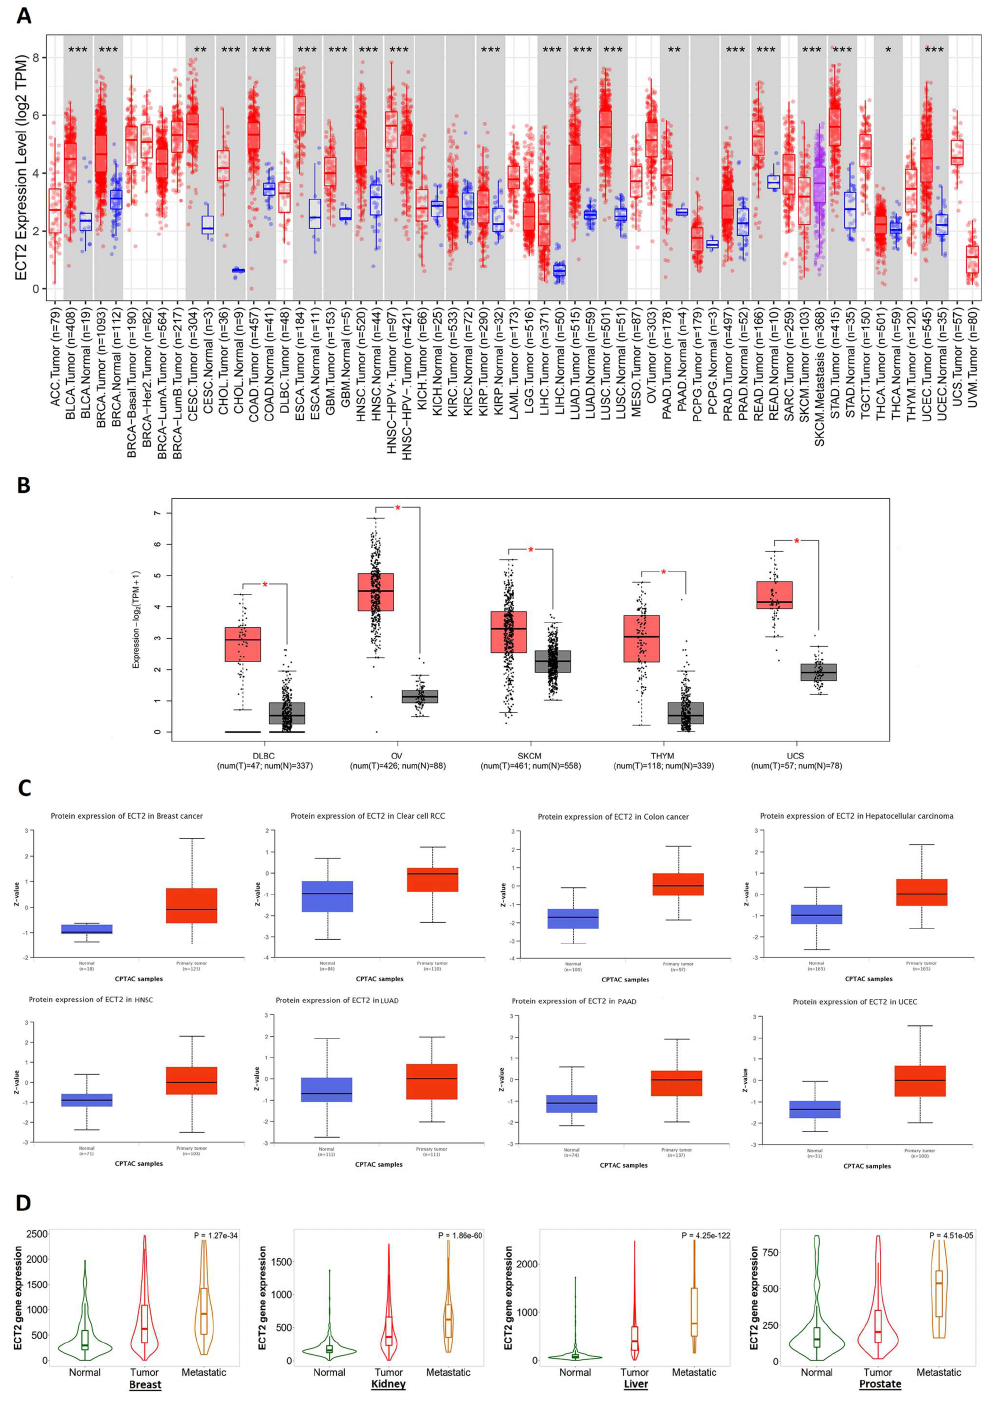
Figure 1. ECT2 expression assessment in human cancers. ( A ) Differential expression of ECT2 in